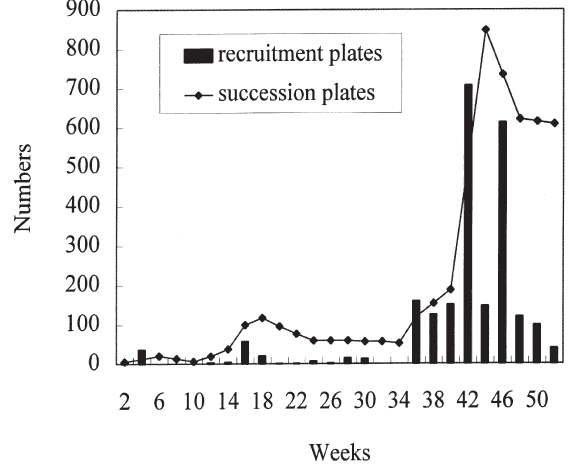
F IG . 3. – Growth curve of Balanus trigonus. Y = 0.2988x, r 2 =